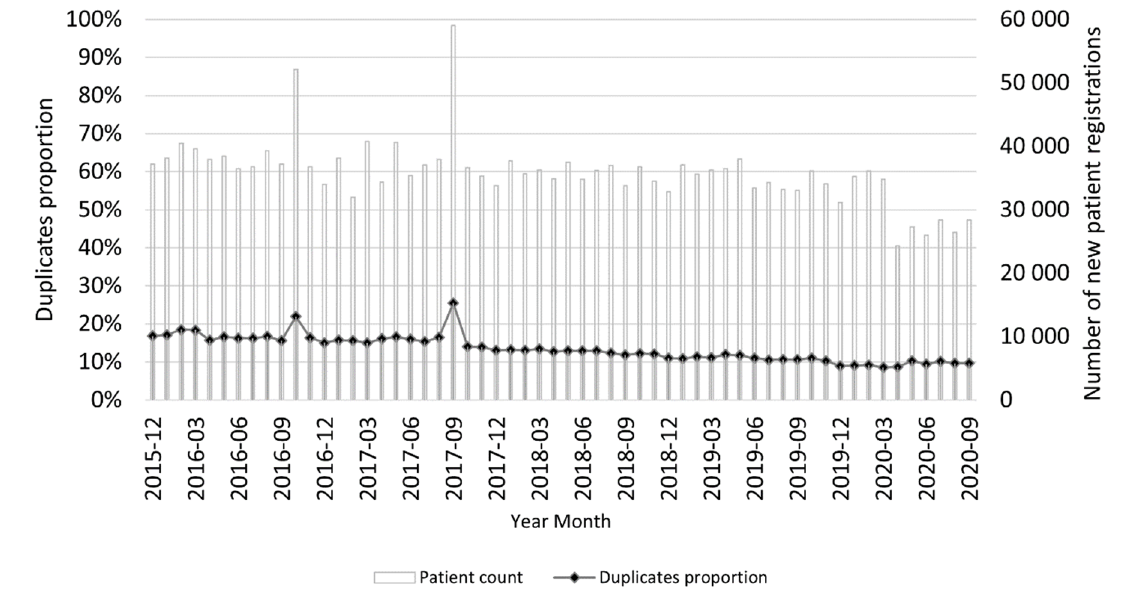
Figure 3: New patient registrations and proportion of duplicates created at public health facilities between December 01, 2015 and